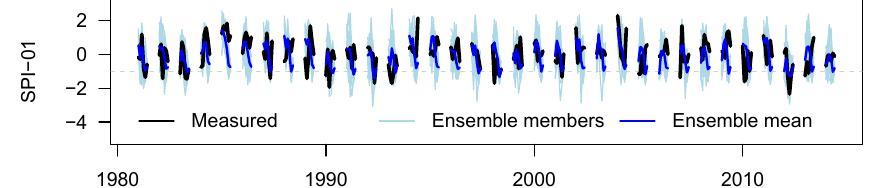
Figure 6. Time series of the seasonal forecast of SPI 1 in the Castanhão subcatchment given by ECMWF:EQM. Only periods from January to June are shown. The threshold “moderate drought event” is given by the grey dashed